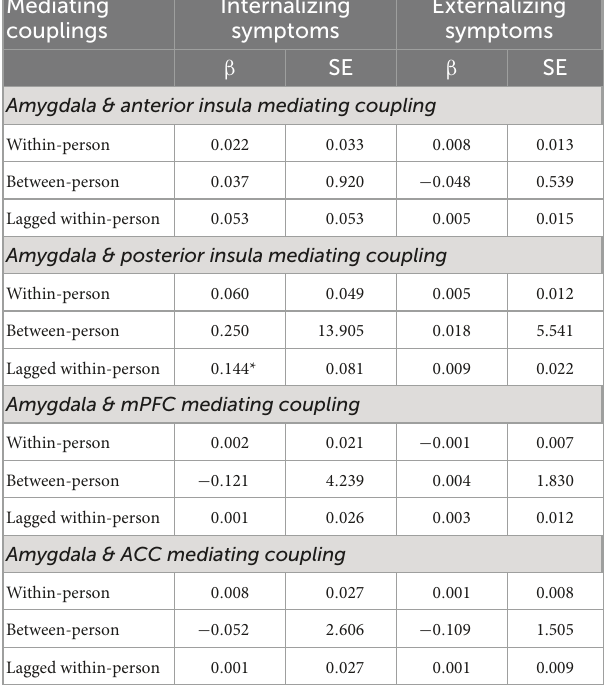
TABLE 3 Indirect effects of peer victimization on internalizing and externalizing symptoms through resting-state functional connectivity. Mediating